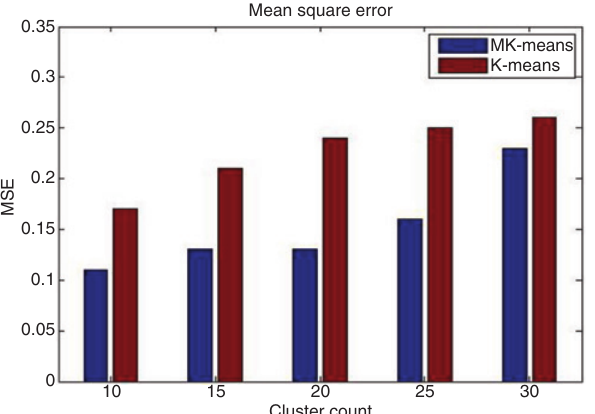
Figure 7: Performance Comparison of MSE Plots by Varying Cluster